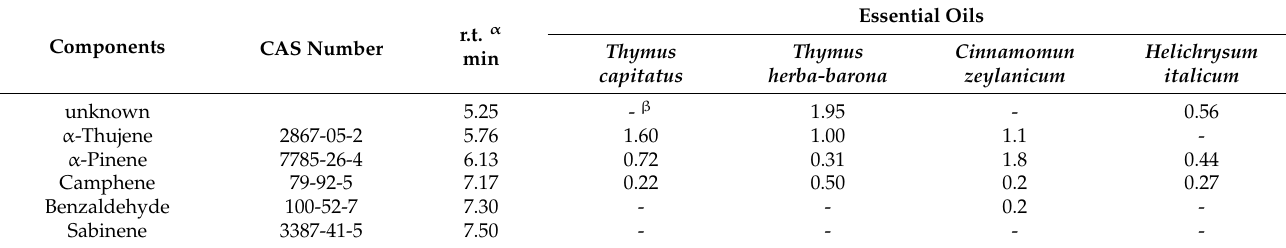
Table 3. Chemical characterization (% w/w ) of the essential oils that showed the highest activity against Ascosphaera apis by means of gas chromatography–flame ionization detector (GC/FID) and gas chromatography–mass spectrometry analysis